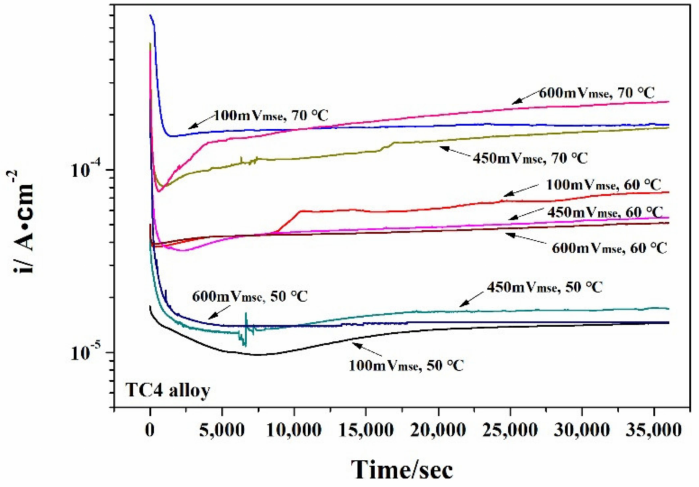
Figure 5. Current density vs. time plots recorded on TC4 alloy during potentiostatic